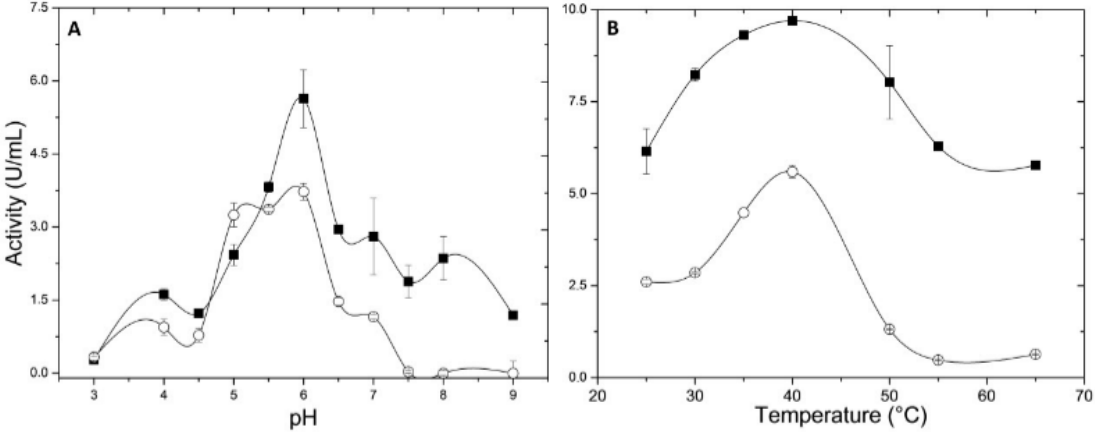
Figure 3. Fusarium verticillioides free lipases characterization. ( A ) pH effect in enzymatic activity; ( B ) temperature effect in enzymatic activity. Symbols: - ■ - Lip1; - ○ - Lip2.